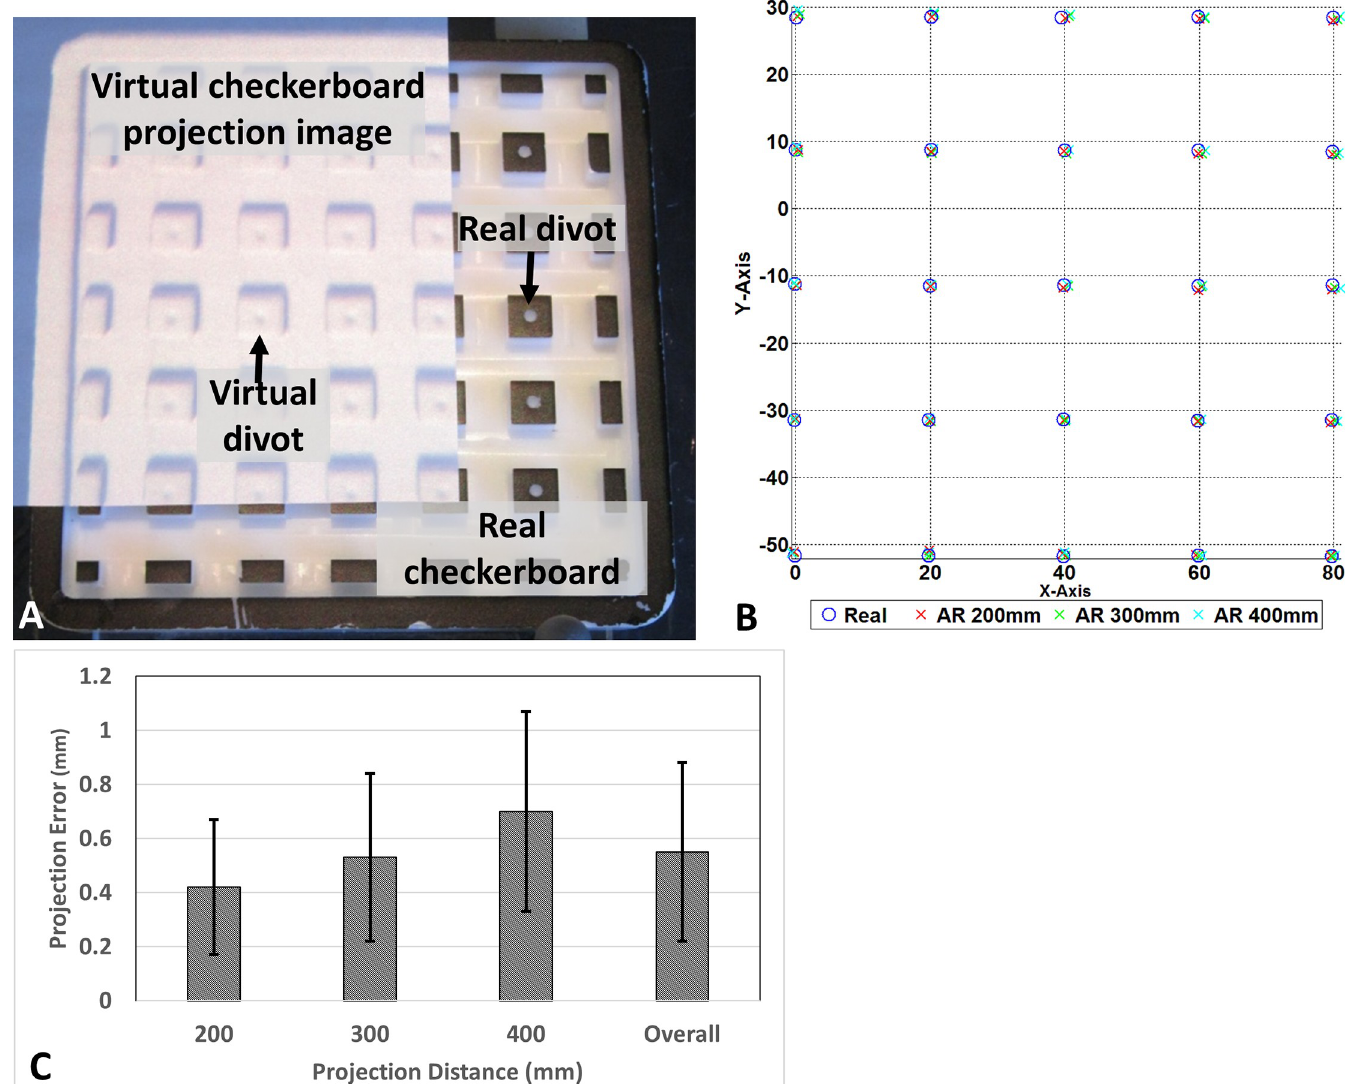
Fig 6. Accuracy estimation of augmented reality navigation system. (A) CBCT generated virtual checkerboard overlaid on a real checkerboard, (B) graphical representation of localization for each divot from various projection distances, (C) projection error at varies projection distance.